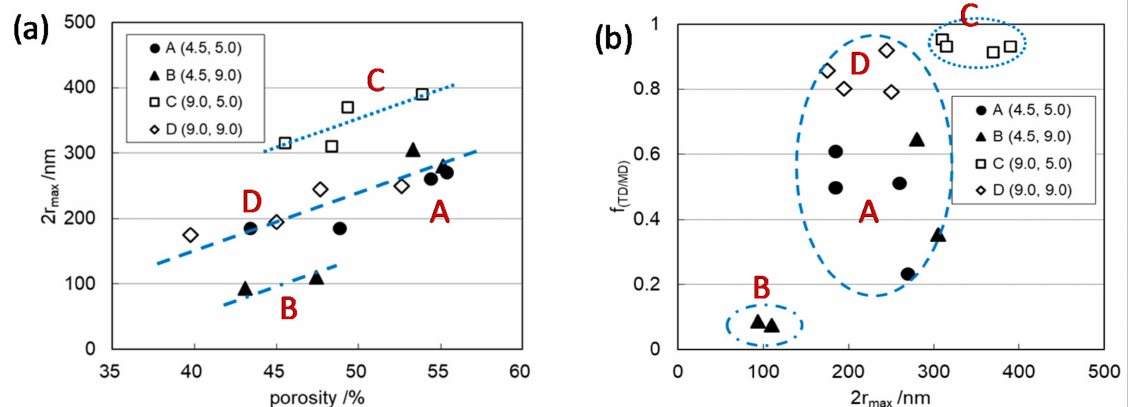
Figure 11. ( a ) Change in mode pore size (2 r max ) as a function of polyethylene (PE) membrane porosity, and ( b ) correlation between the anisotropy index ( f (TD/MD) ) evaluated by the elastic modulus in machine direction (MD) and transverse direction (TD) and the mode pore size, 2 r max . The display in the figure represents the four groups of membranes (A, B, C, D) prepared in the process of different stretching conditions: e.g., A (4.5, 5.0); membranes prepared with the stretching ratios of